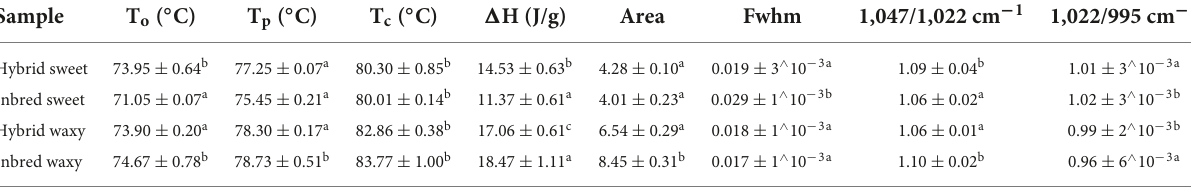
Values are represented as the mean ± SD; values in the column with different superscript letters are significantly different at P < 0.05. Abbreviations in Tables 1 , 2 are explained in the text.